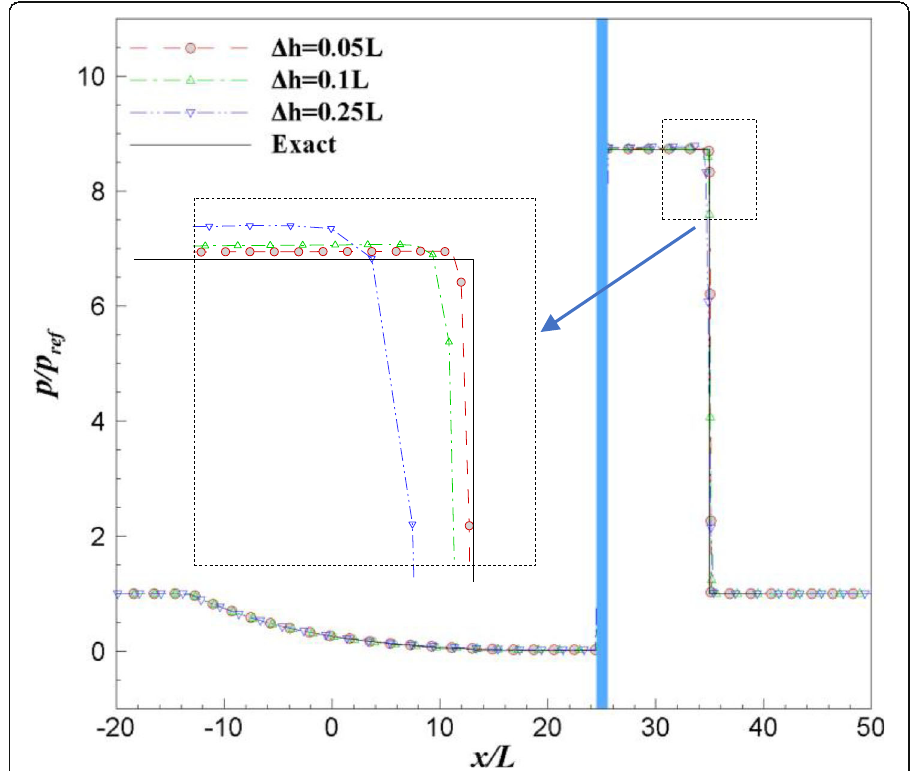
Fig. 8 Grid convergence study of the pressure distribution along